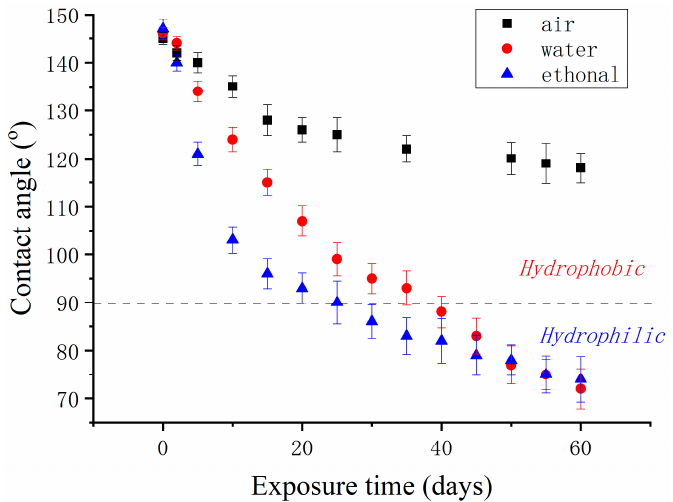
Figure 7. Change of water contact angle of FAS-grafted alumina membrane after exposure to air, water, and ethanol, respectively, as a function of exposure time (days).